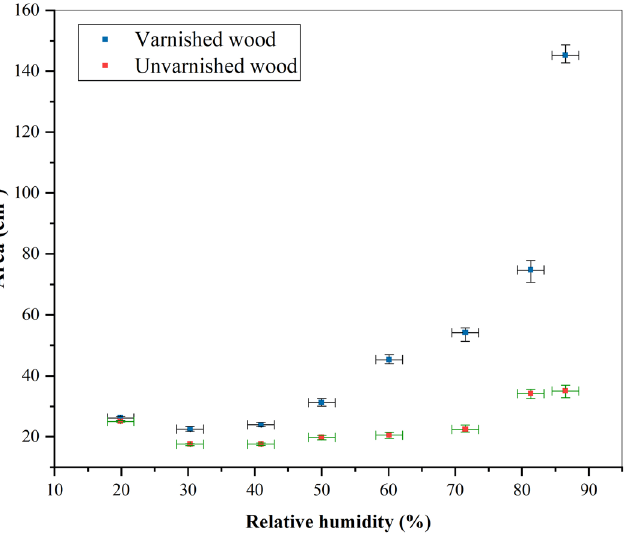
Figure 8. Total area of blood pools ( m i = 4.82 g ± 0.5% , hct = 42.8% ± 2.6% ) at equilibrium as a function of the substrate nature and relative humidity at a temperature of 21 ◦ C . (OriginPro 2018).